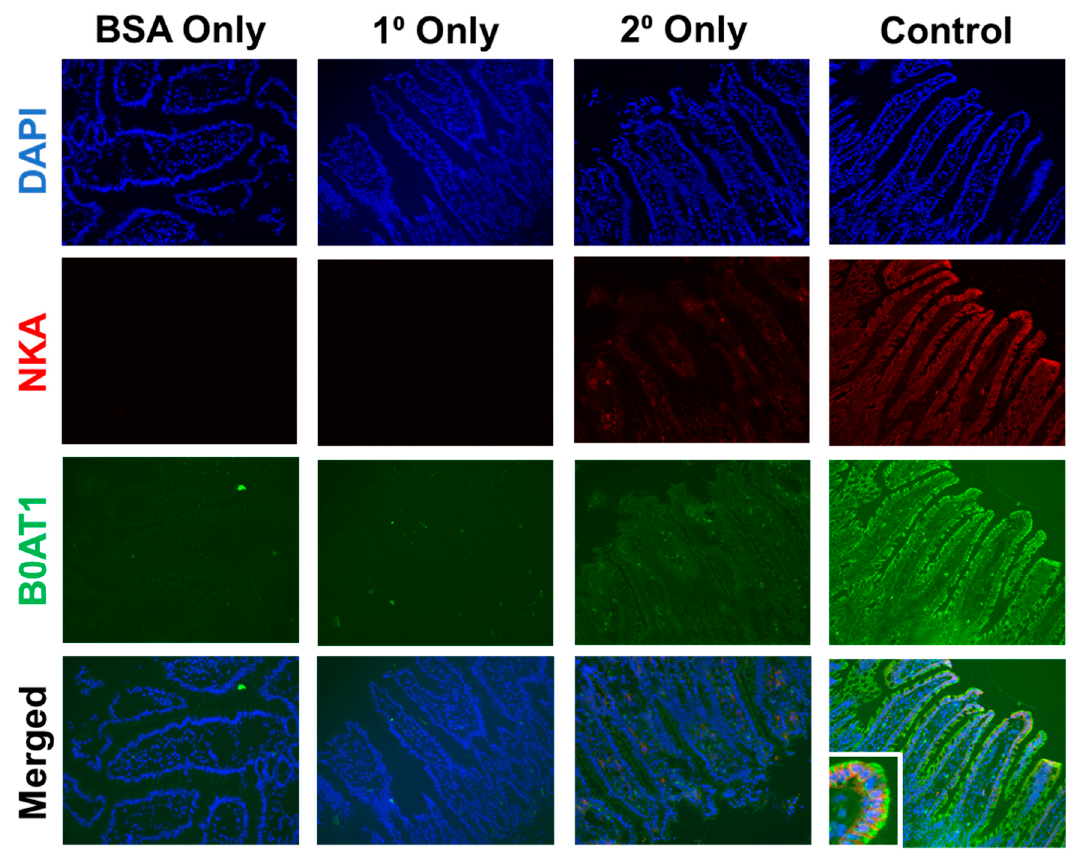
Figure A2. Negative controls for the B0AT1 antibodies showed no significant non-specific binding . Shown are representative images taken using a 20× objective. The green stain represents B0AT1. The red stain represents the Na-K-ATPase α -1 (NKA) subunit. The blue stain represents DAPI.